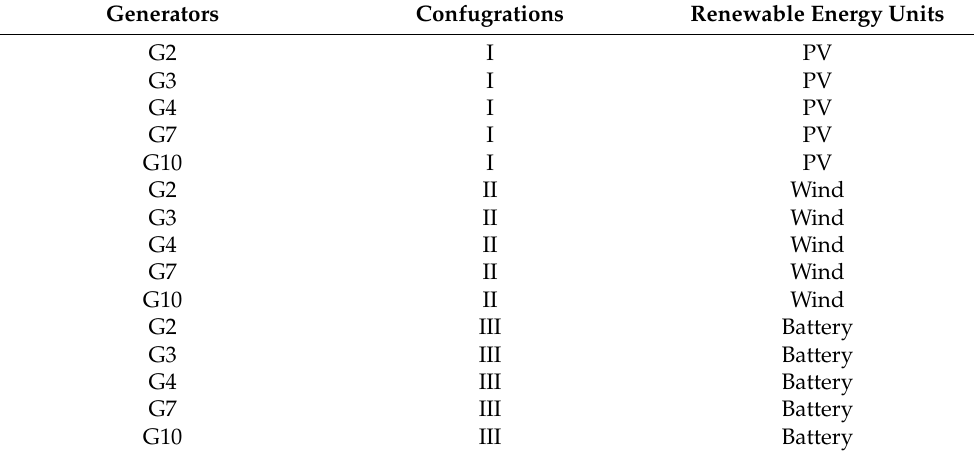
Table 7. Generator Configurations.